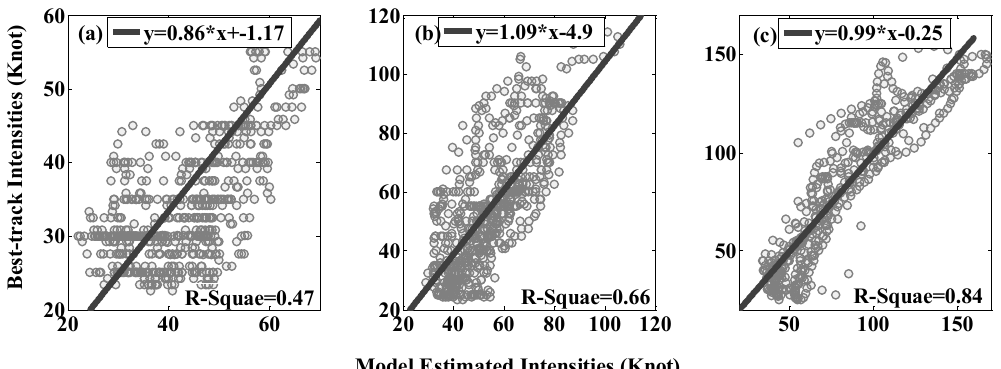
Figure 7. Scatterplots of the model estimated vs. best-track intensities for groups in which the maximum intensity: ( a ) <60 knot; ( b ) 60–120; and ( c ) >120 knot in the independent tests. The solid lines indicates the goodness of the regression of the scatterplot, which are obtained using the least square method. Table 5. Statistics produced in the independent tests.